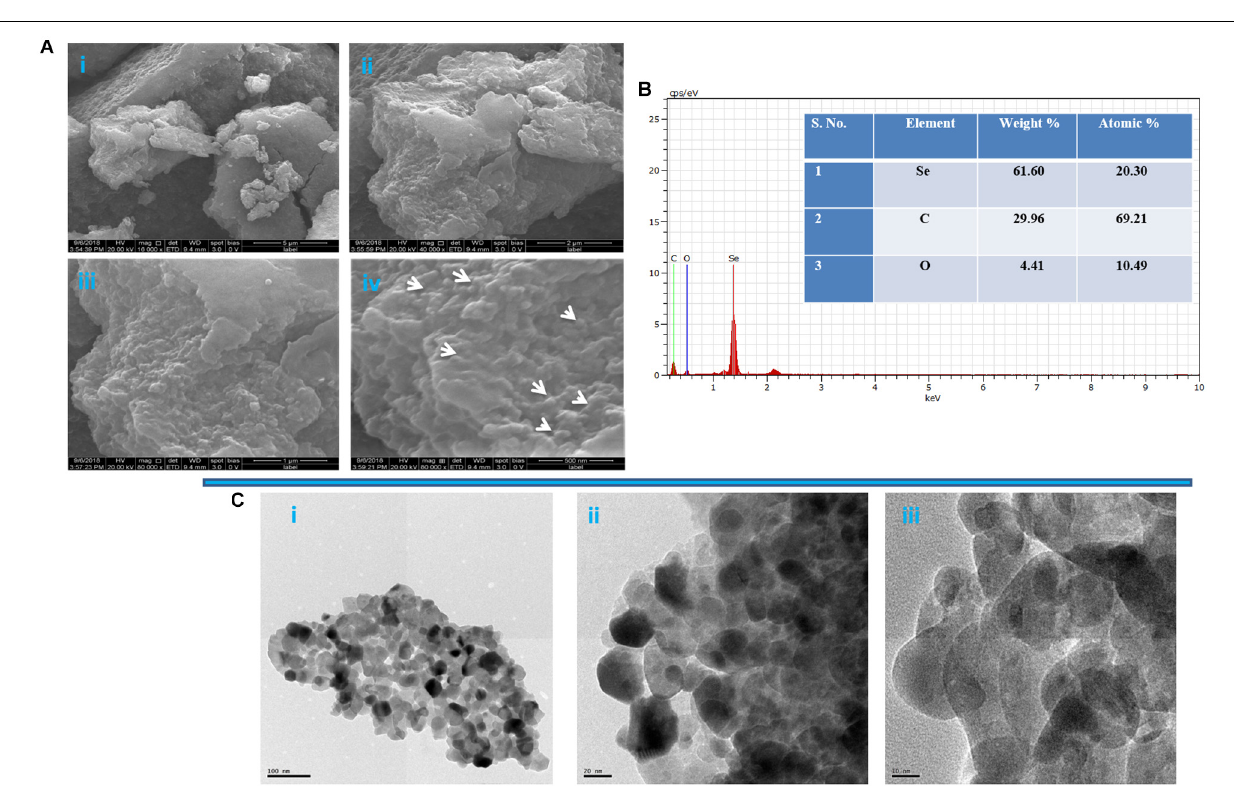
Frontiers in Microbiology |